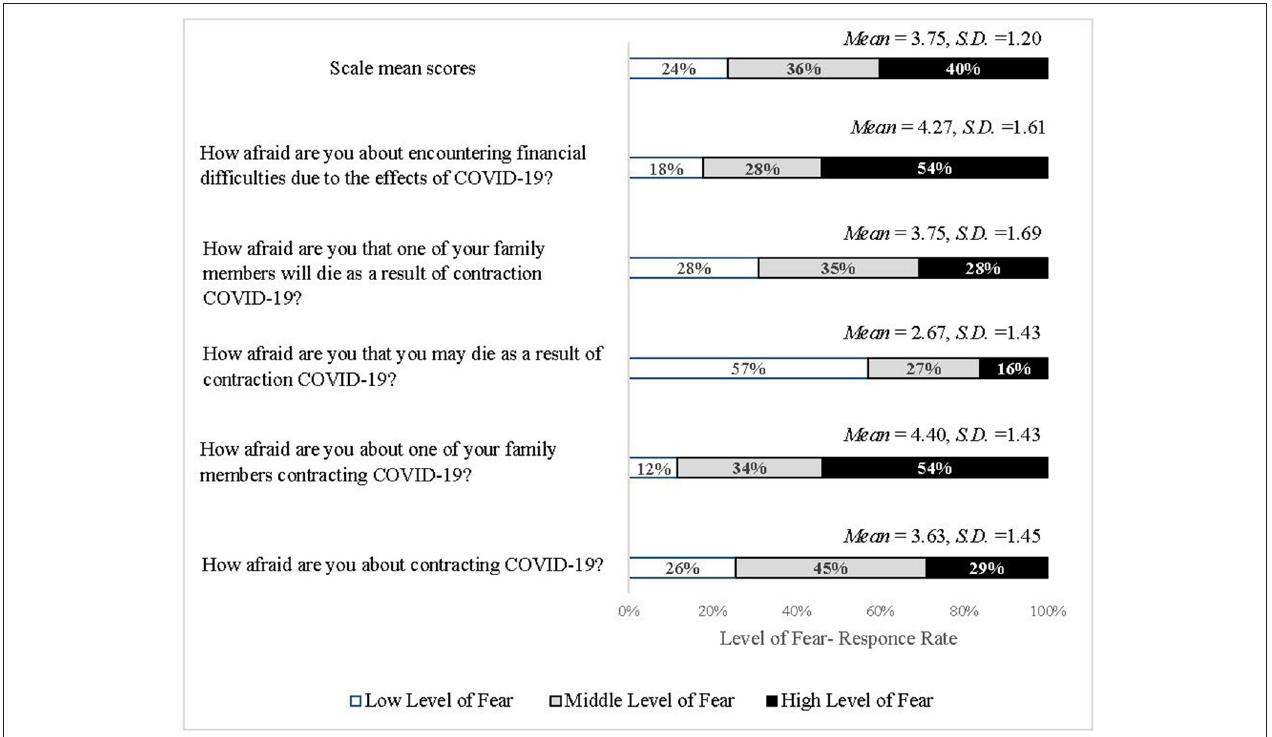
FIGURE 2 | Distribution of responses, means and standard deviations on fear of COVID-19 items ( N =